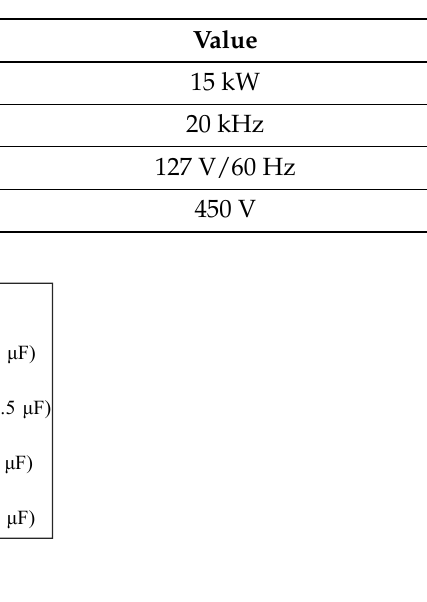
Table 1. Converter specifications.